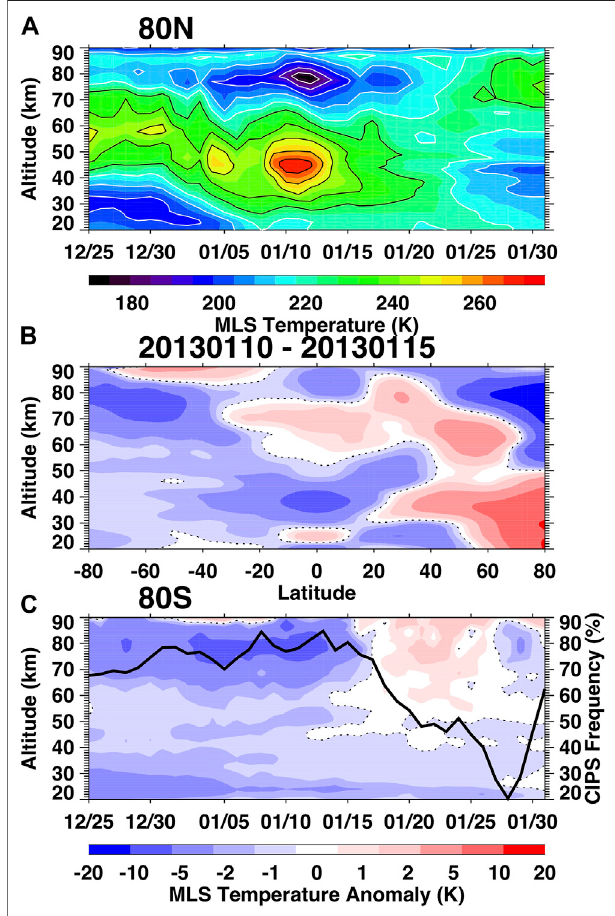
FIGURE 1 | (A) Altitude-time section of zonal mean MLS temperature averaged at 80 ° N from December 25, 2012 through January 31, 2013, (B) Latitude-altitude section of zonal mean temperature anomalies (deviations from the time mean) averaged from 10 to 15 January 2013, (C) Altitude- time section of temperature anomalies at 80 ° S from December 25, 2012 through January 31, 2013. The thick black line indicates daily CIPS PMC frequencies(numberofpixelsinwhichaPMCwasdetectedrelativetothetotal number of pixels, in %) at 80 ° S for clouds with albedos greater than 5 × 10 – 6 sr − 1 , smoothed over 3